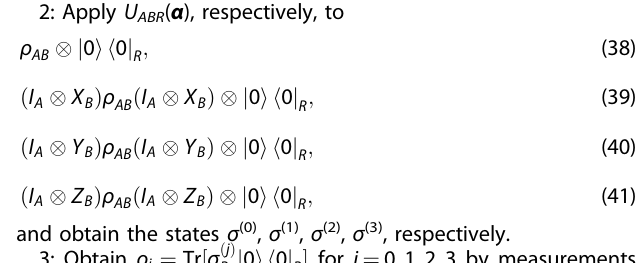
Algorithm 4 . Variational logarithmic negativity estimation 1: Input: a 2-qubit quantum state ρ AB and parameterized circuit